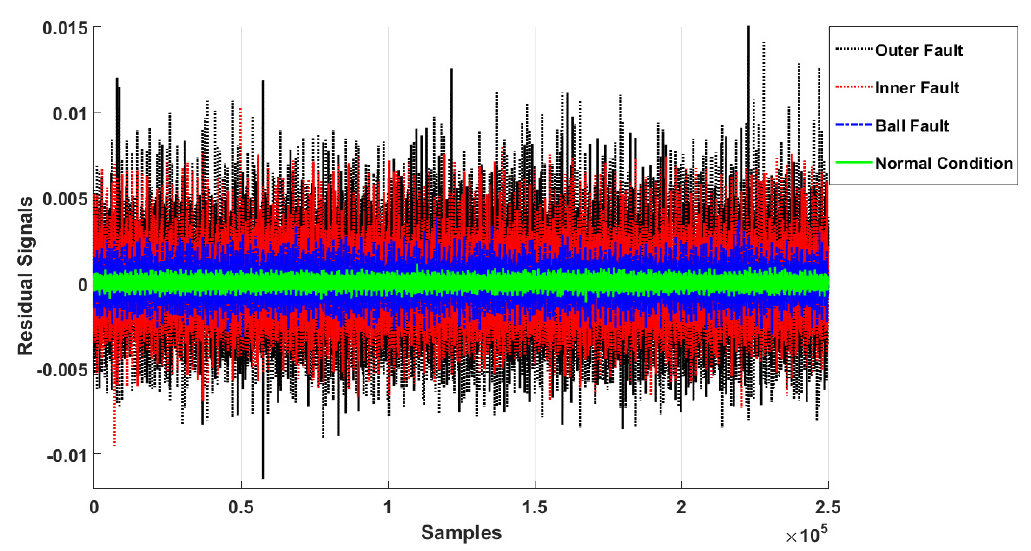
Figure 3. Residual signals in normal and abnormal conditions using fuzzy orthonormal-ARX adaptive fuzzy logic-structure feedback (PM) observer.